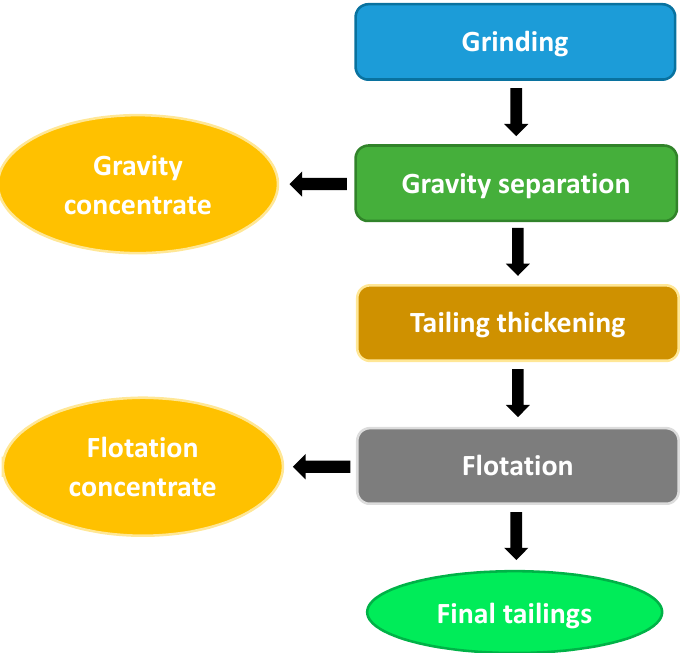
Figure 9. The flow chart of gravity–flotation combined beneficiation.